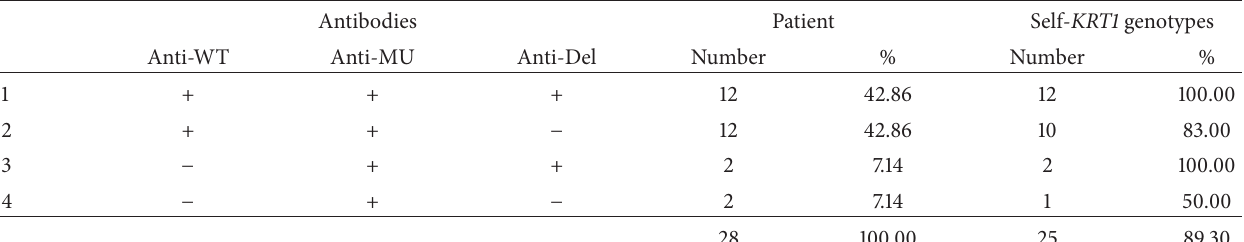
Table 3: Comparison of antibodies patterns and patient’s self KRT1